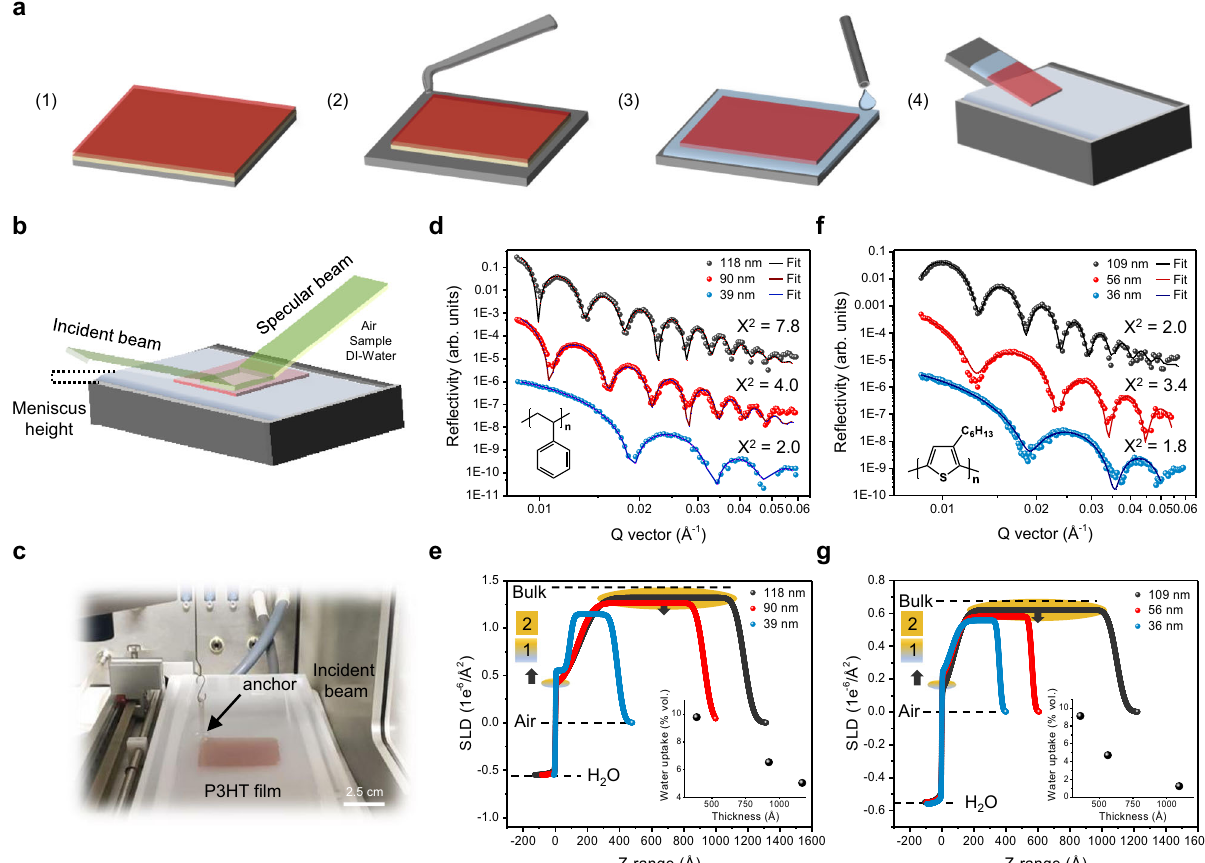
Fig. 5 Monitoring water uptake within PS and P3HT thin fi lms via neutron liquid re fl ectometry. a Sample loading with (1) spun cast composite fi lm with PSS underlayer, (2) removal of fi lm edge, (3) fl oating of fi lm, (4) transfer into trough. b Illustration of NR experiment with fi lm fl oating on the water surface. c Photograph of a 5 × 5 cm P3HT fi lm of 36 nm in thickness anchored within the DI-water trough. d Re fl ectivity vs. wave vector for PS fi lms of varying thickness. e PS SLD pro fi le in Z -direction. Insert is of PS water uptake dependence on thickness. f Re fl ectivity vs. wave vector for P3HT fi lms of varying thickness. g P3HT SLD pro fi le in Z -direction. Insert is of P3HT water uptake dependence on thickness. The shaded regions corresponding to the sublayer and top layer represent the layers 1 and 2 depicted in Fig.